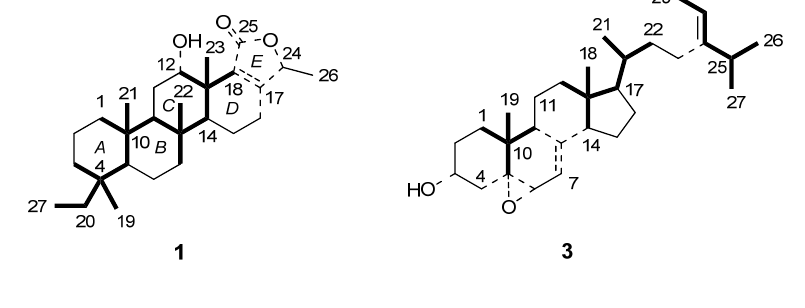
Table 1. 1 H- (600 MHz) and 13 C-NMR (150 MHz) data for 1 in C